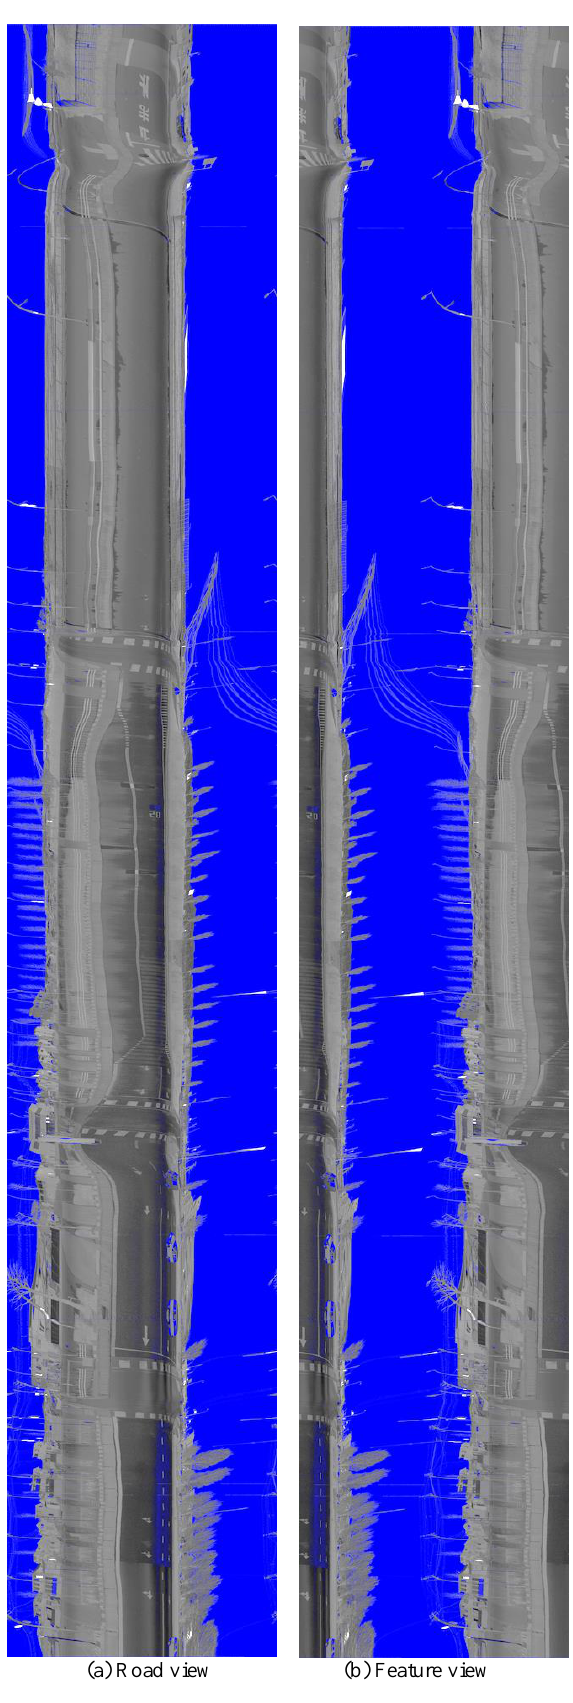
Figure 5. Trajectory-based point-cloud images